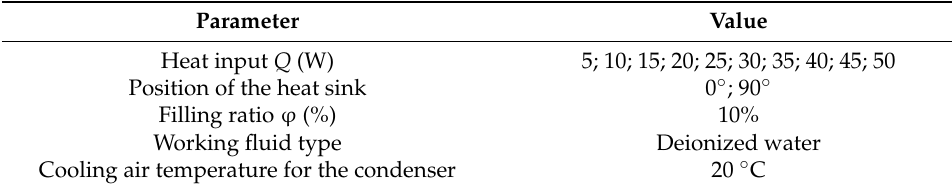
Figure 4. Heat sinks used for cooling ( a ) single THP; ( b ) double THPs. Table 2. Heat transfer test parameters.